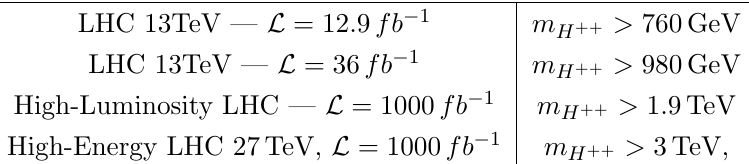
Table 2 . Summary of collider bounds on the doubly charged scalar in our model using